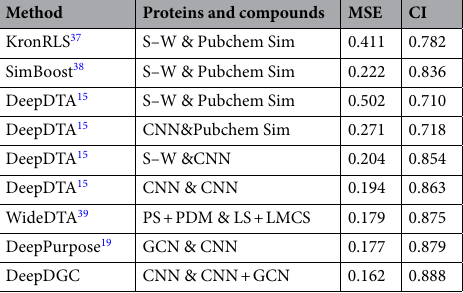
Table 2. Performances of various methods on KIBA dataset.